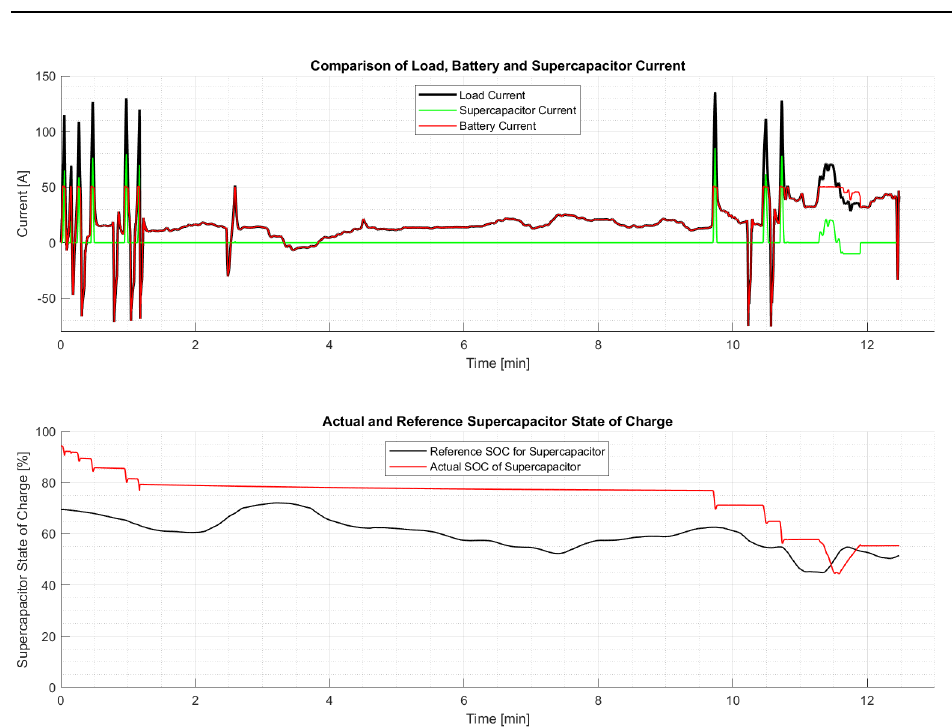
Figure 8. Current distribution and supercapacitor state of charge (actual/reference value) for simu- lated journey on